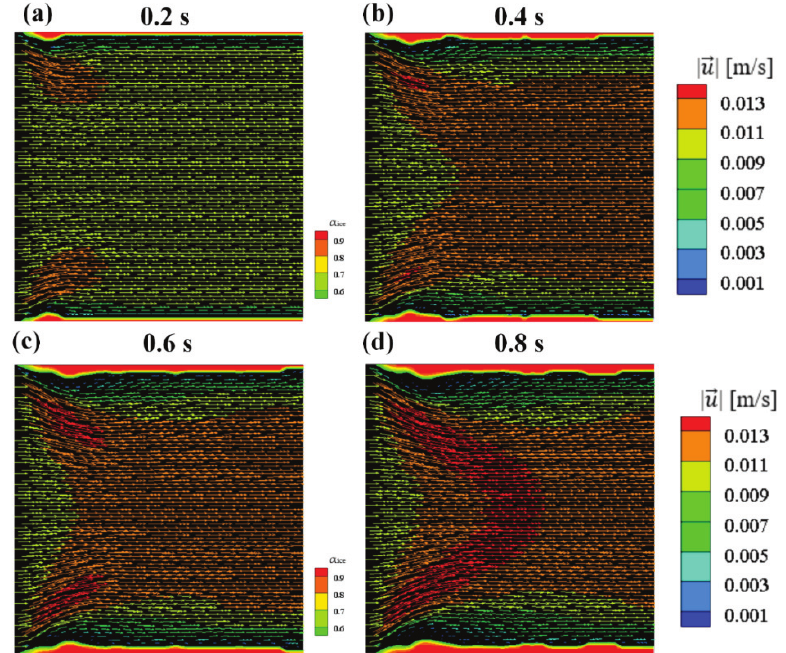
Figure 12. Vector graph of fluid velocity (ms − 1 ) of water and n-hexanol at various moments ( a ) 0.2 s, ( b ) 0.4 s, ( c ) 0.6 s, and ( d ) 0.8 s.